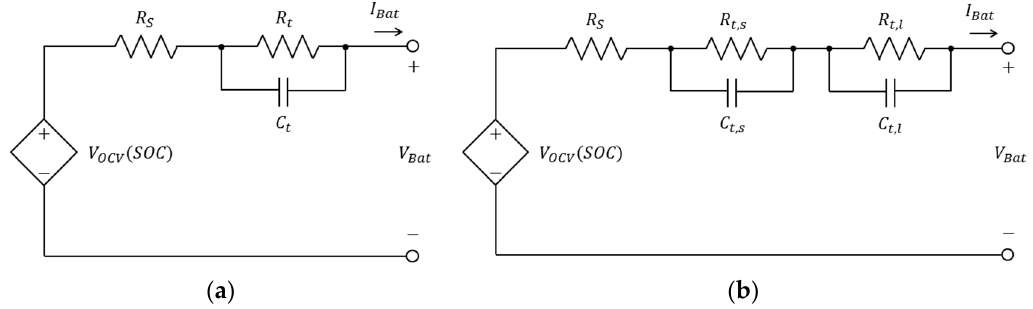
Figure 1. ( a ) Thevenin-based model, 1 RC network. ( b ) Thevenin-based model, 2 RC networks .